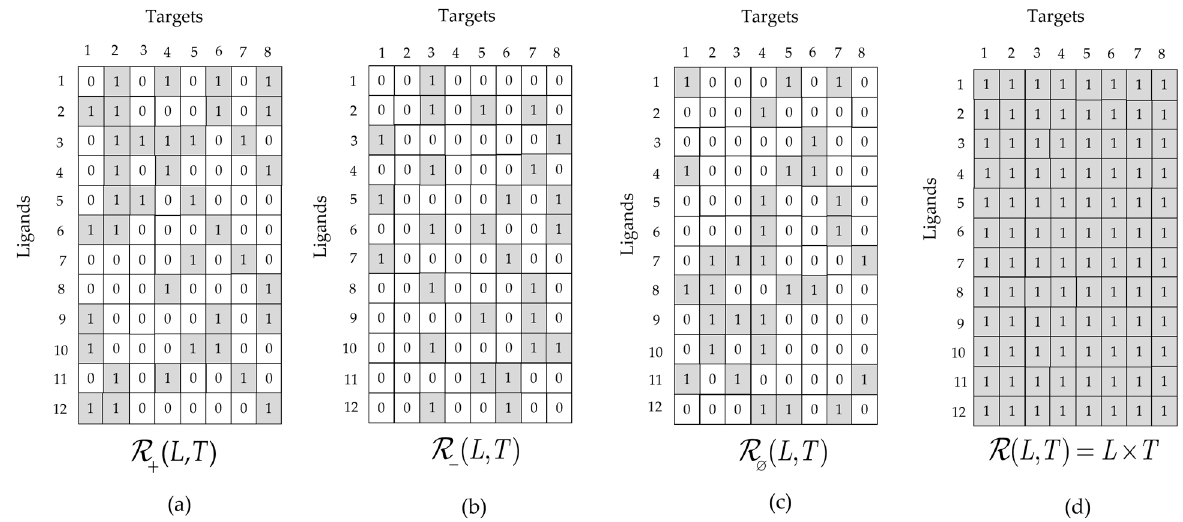
Figure 3. Example of three binary subrelations: ( a ) represents the set of active LT pairs, ( b ) represents the set of inactive LT pairs, ( c ) represents the set of null LT Pairs, and ( d ) represents their set-theoretic union, which is equivalent to the reference set L × T .